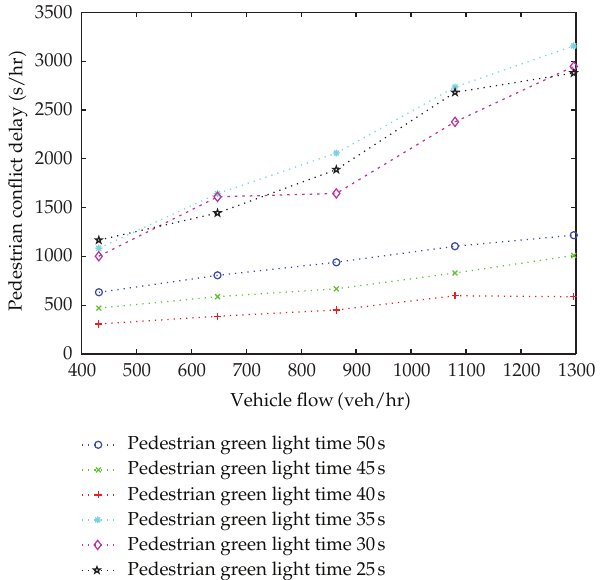
Figure 9: The relationship between pedestrian conflict delay and green light